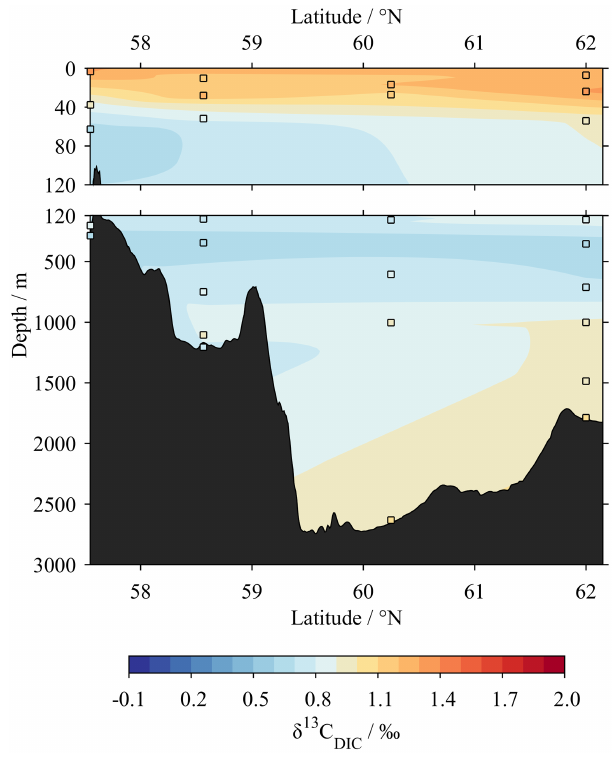
Figure 8. Meridional section of δ 13 C DIC results from this study, from south to north in the eastern subpolar North Atlantic Ocean (green in Fig. 1). Coloured squares show actual sample locations and δ 13 C DIC values. Bathymetry data are from the GEBCO_2014 grid, version 20150318, http://www.gebco.net.